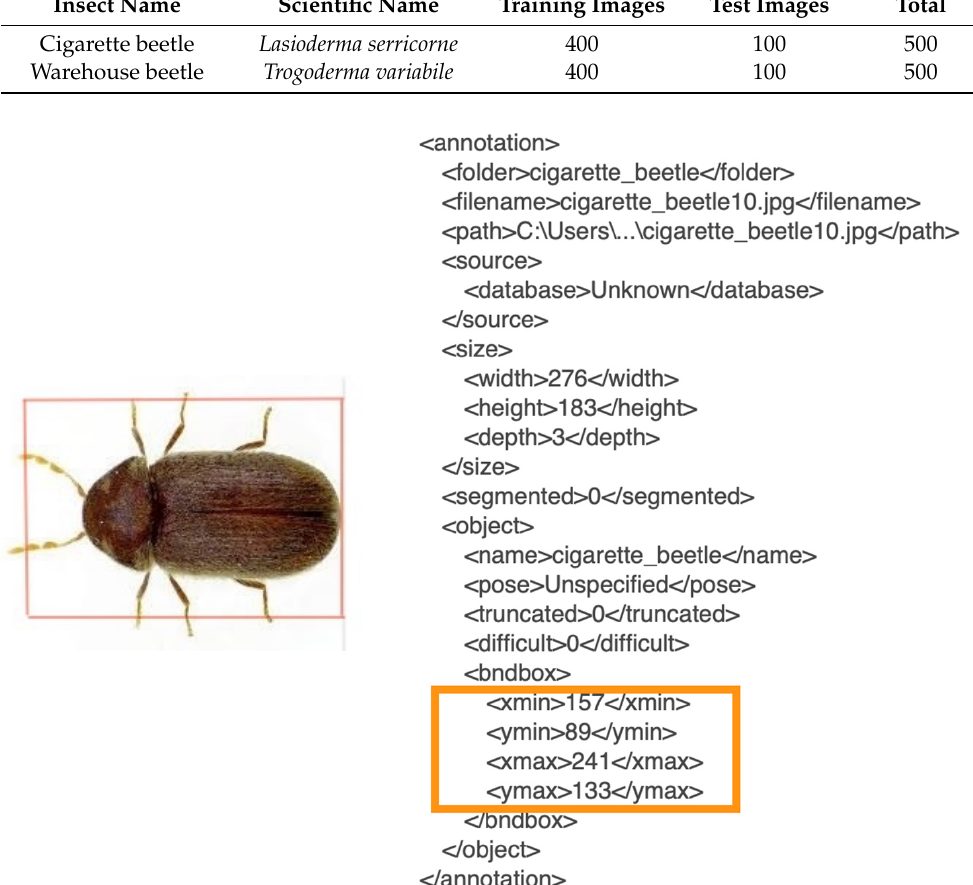
Figure 5. Annotation of the captured image.